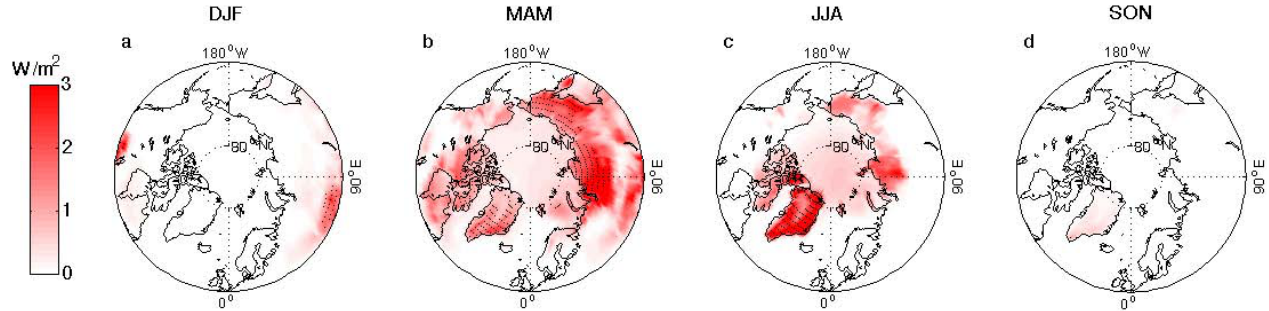
Fig. 5. Radiative forcing, 1F , in Wm − 2 , for each season due to light-absorbing particles in snow and sea ice. Carbon dioxide is constant at a year 2000 level. Hashes indicate where differences are significant to 95% confidence in this and other figures where they appear.